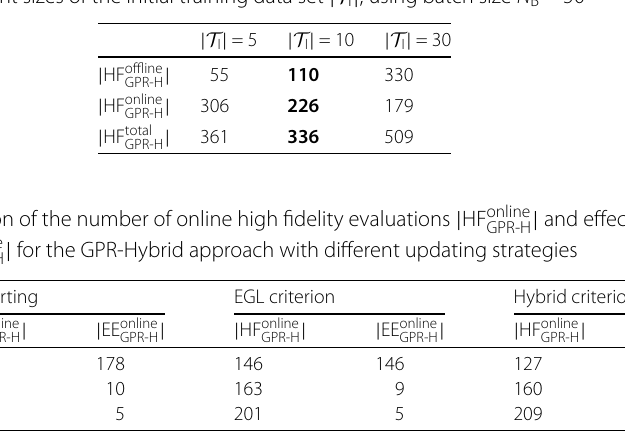
Table 1 Comparison of the number of high fidelity evaluations for the GPR-Hybrid approach | for different sizes of the initial training data set | T | HF GPR-H